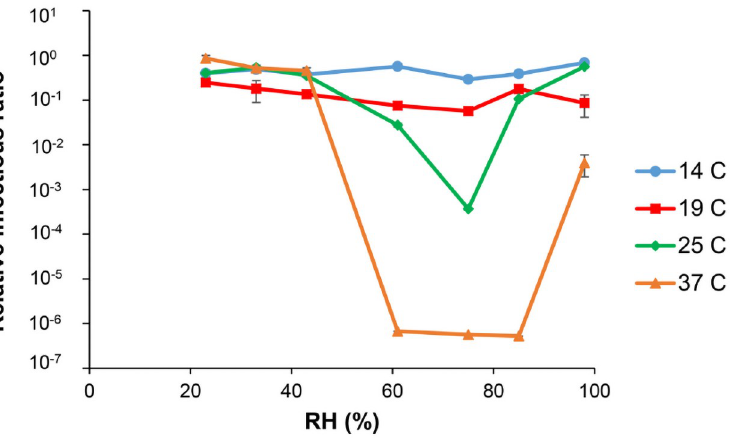
Fig 4. Phi6 infectivity with temperature and RH. Original data from Prussin et al [41] on the relationship between temperature, RH and Phi6 infectivity. Phi6 is an enveloped virus used as a model for influenza, coronavirus and other respiratory viruses. The error bars are shown but too small to be visible in the